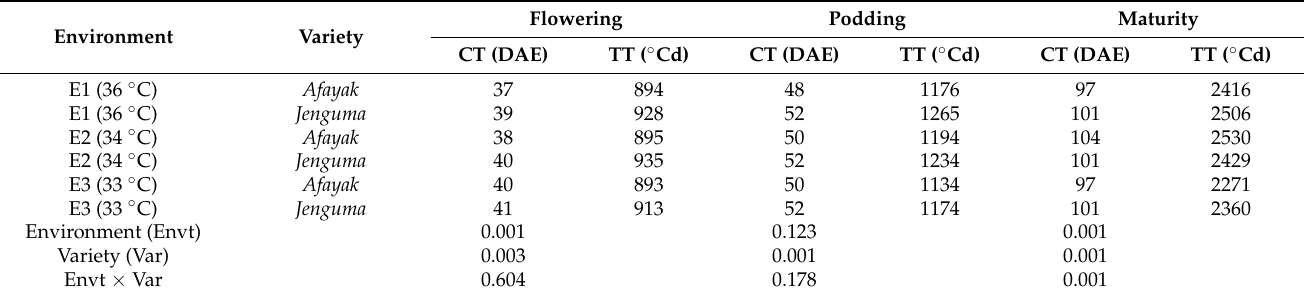
Table 1. Chronological days and thermal time for developmental stages.